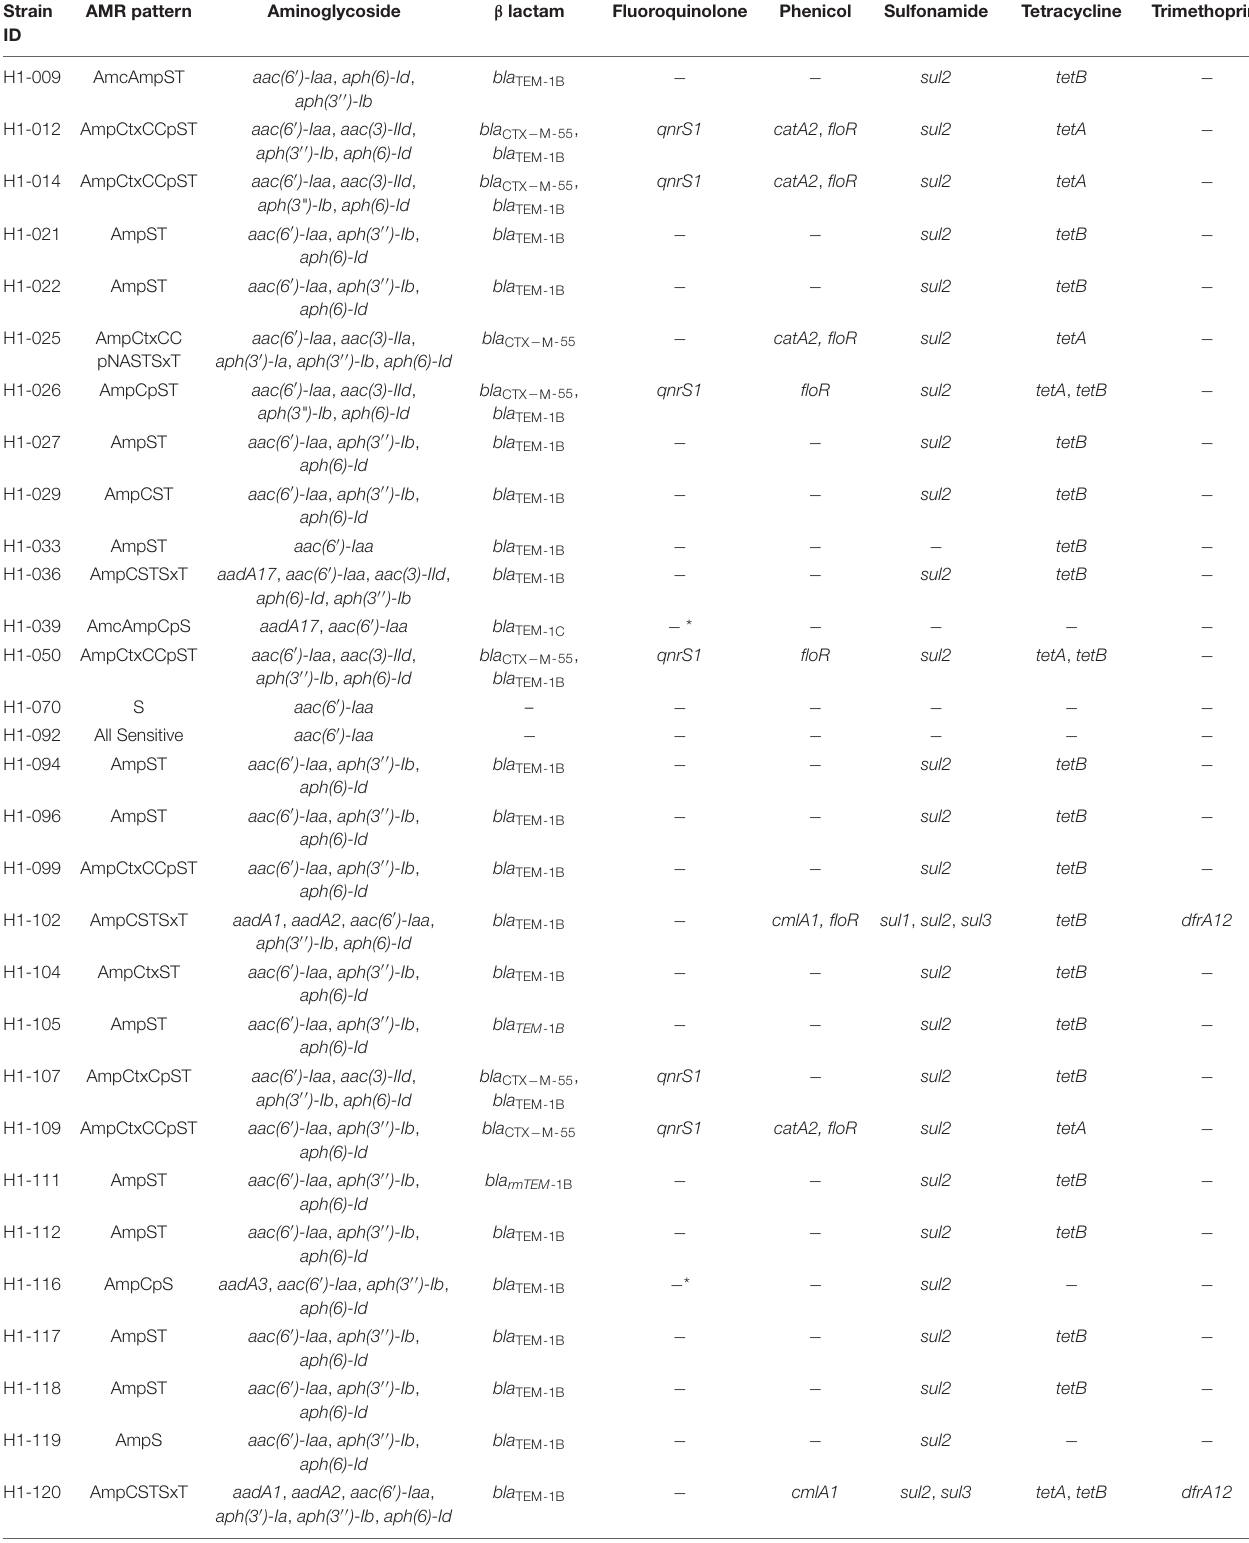
TABLE 4 | Phenotypic AMR patterns related to genotypic AMR genes found in selected isolates ( n = 53). Strain AMR ID